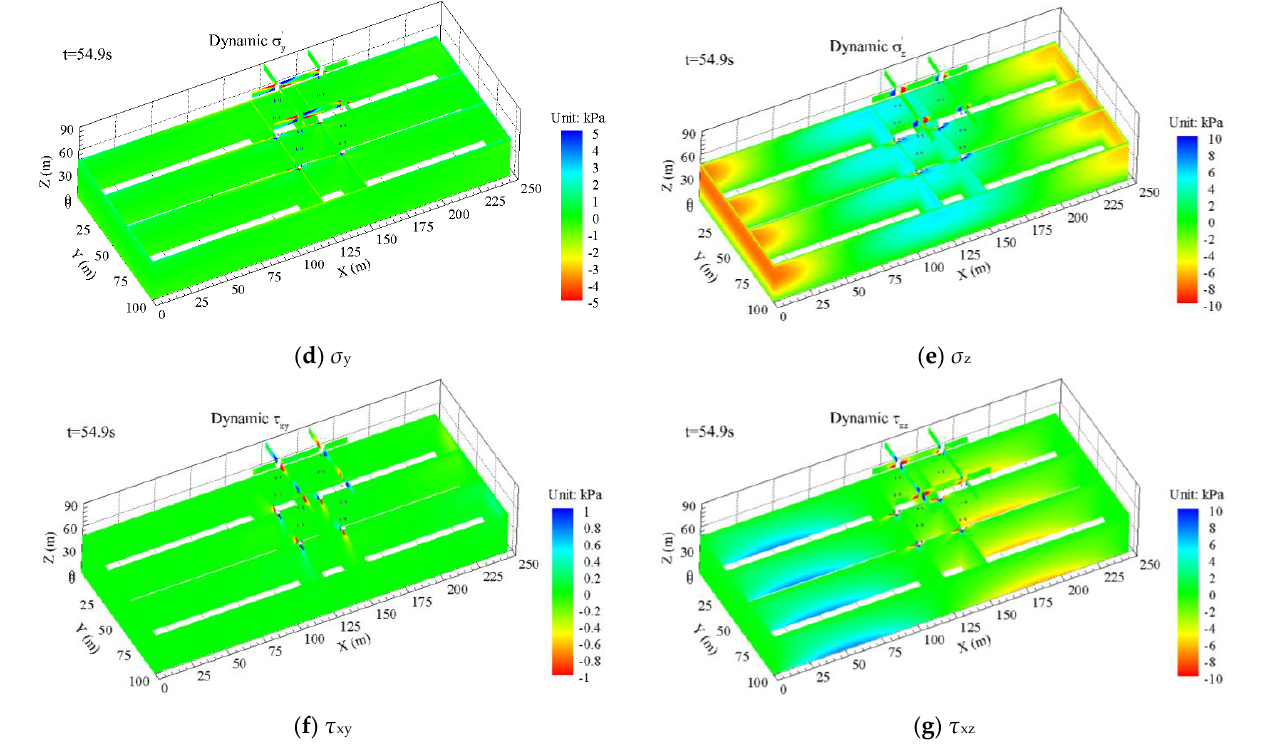
Figure 14. Wave surface, and the distribution of dynamic pore pressure, effective stress, and shear stress in the jack-up platform and its seabed foundation when a wave trough reaches the jack-up platform in Case 2 ( t = 54.9 s).